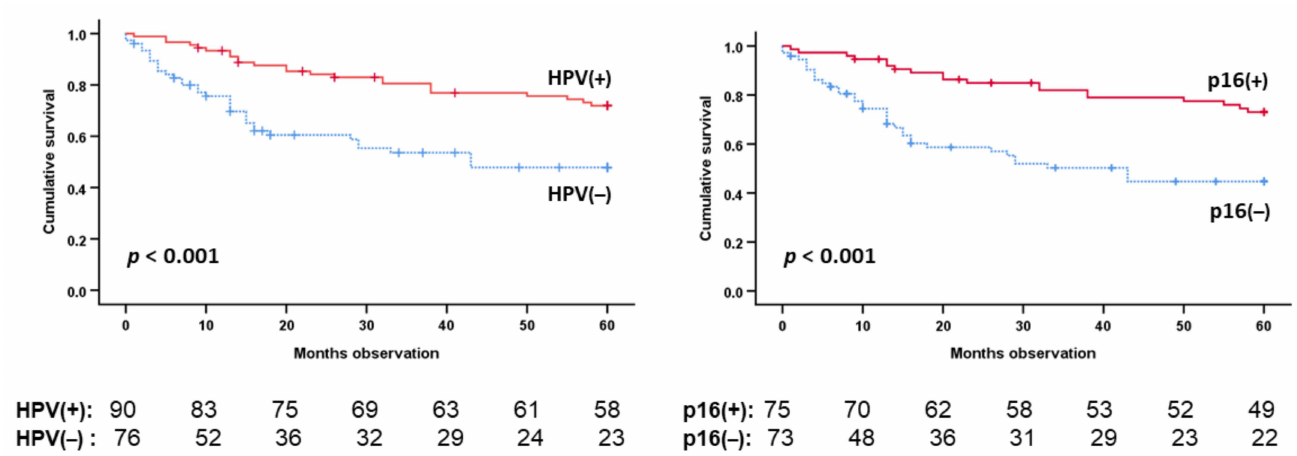
Figure 3. Five-year DSS (all patients) by tumor HPV ( left ) or p16 ( right ) status. HPV determined by PCR. p16 determined by immunohistochemistry. Two bottom lines each figure: Number patients at risk. Survival curves and statistics by Kaplan–Meier plot with Log rank p